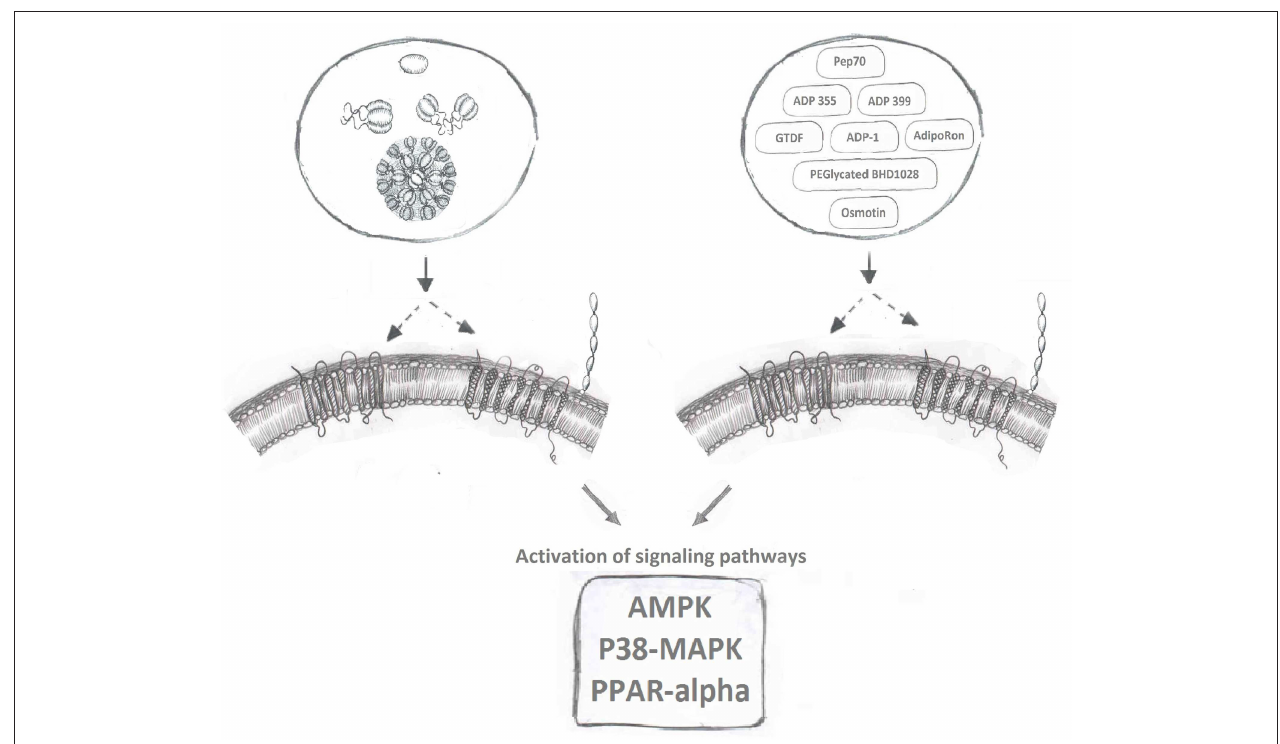
FIGURE 2 | Adiponectin receptor agonists. Binding of full-length and globular adiponectin to adiponectin receptors with seven transmembrane spanning domains (left side) normally activates downstream signaling pathways, such as AMPK, p38MAPK, and PPAR-alpha. Multiple adiponectin receptor agonists have now been identified to also bind adiponectin receptors and induce these downstream signaling